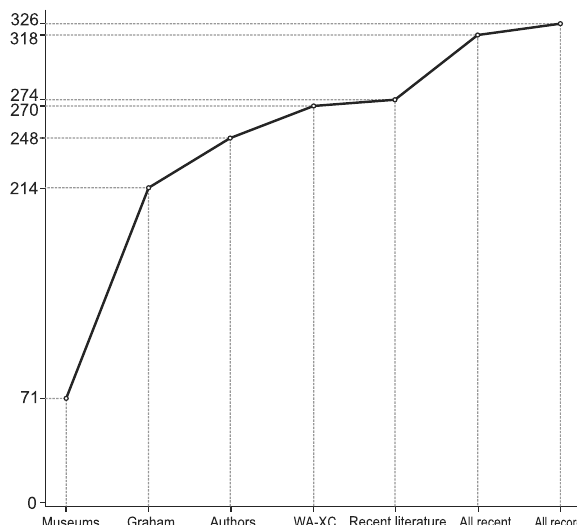
Figure 3. Number of species reported by different sources during different periods in Serra da Cantareira. Museums: specimens depos-